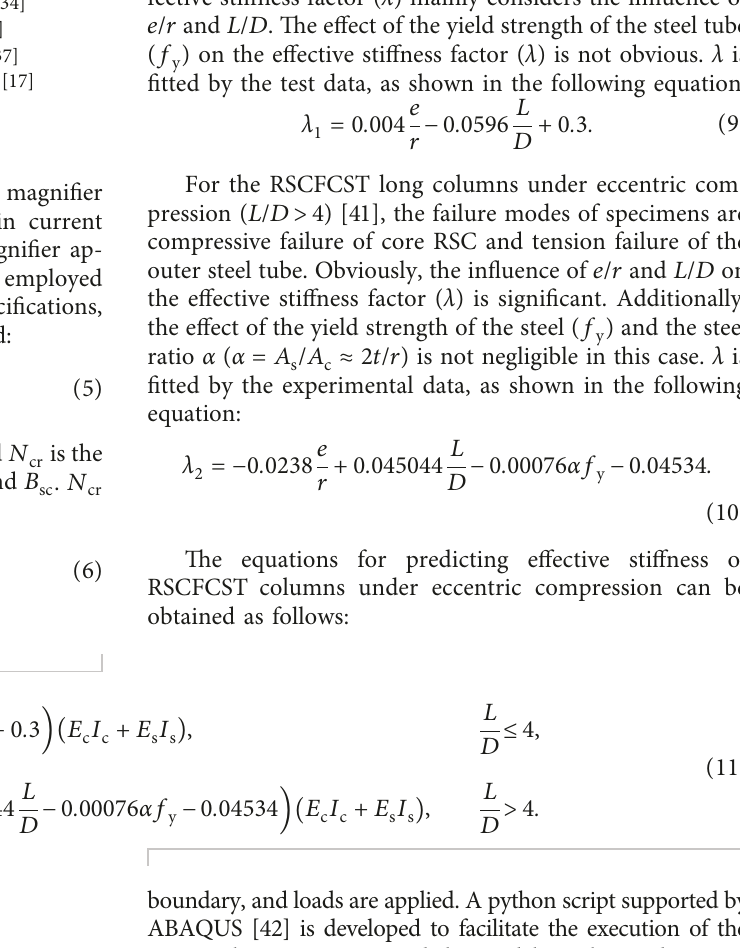
Figure 10, the stress-strain curve of steel can be divided